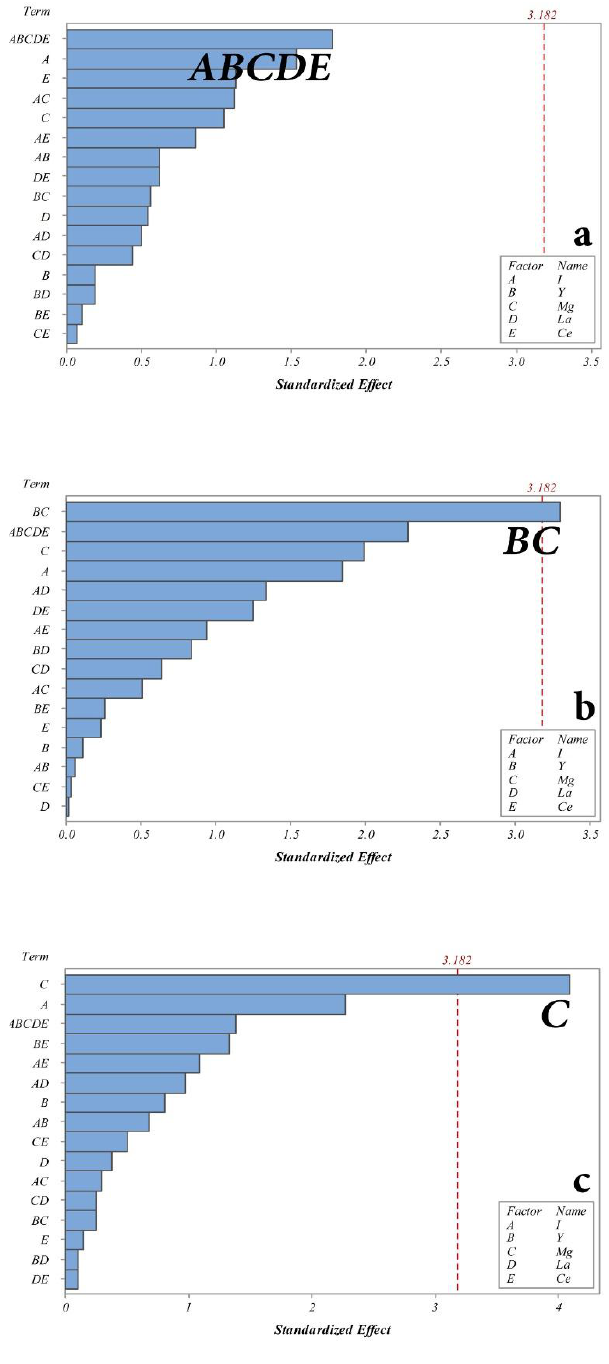
Fig. 8 . Pareto plat of the standardized effects for deposition weight (a), pH (b), conductivity (c). α =